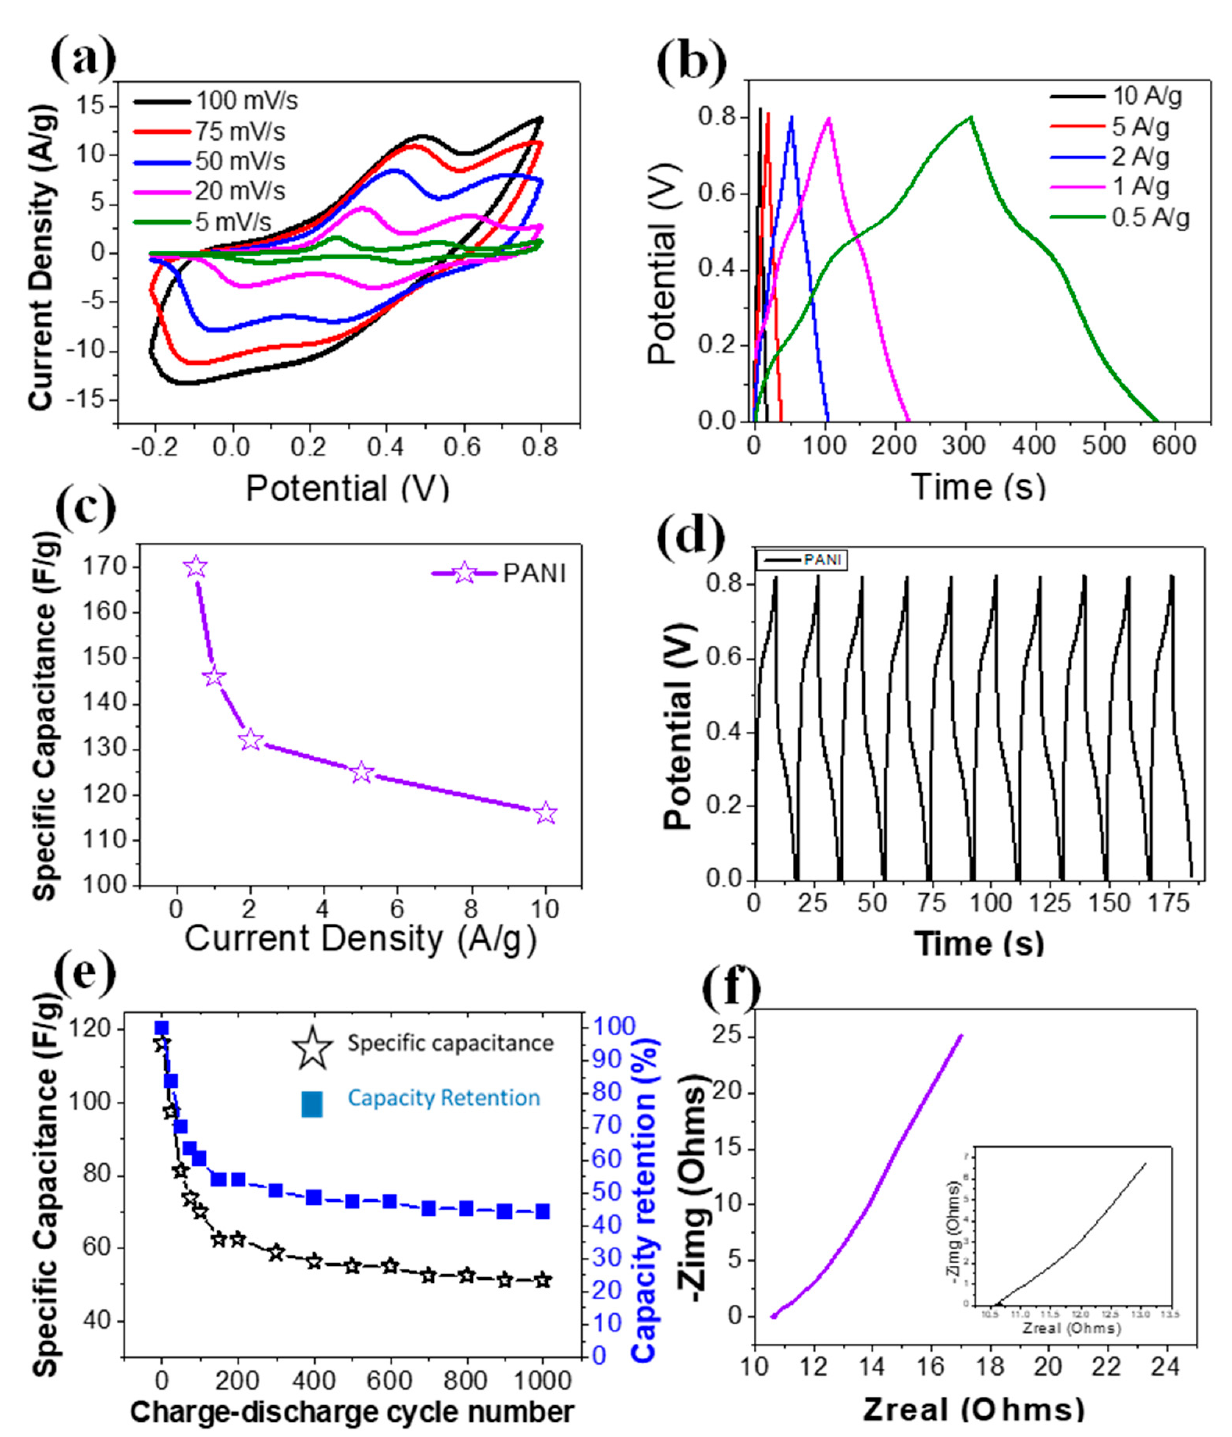
Figure 6. Electrochemical measurements of PLA4Gr6/PANI in 1 M H 2 SO 4 solution: ( a ) Cyclic voltammograms at different scan rates, ( b ) Galvanostatic charge-discharge plots at different current densities, ( c ) Specific capacitance v/s current density plots, ( d ) Starting ten cycles of charge-discharge, ( e ) Cycle test (till 1000 cycles) and ( f ) Electrochemical impedance spectrum.